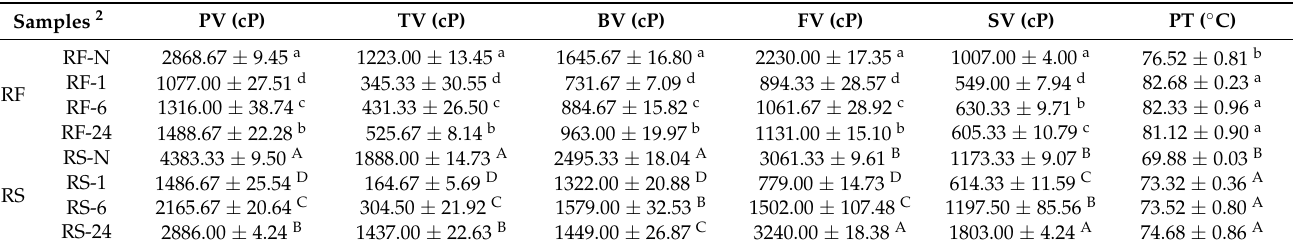
Figure 5. The RVA curves of native and partially hydrolyzed RF and RS. RF represents rice flour and RS represents rice starch; numbers refer to the hydrolysis time (h); RF-N is native rice flour and RS-N is native starch isolated from rice flour. Table 6. The RVA parameters 1 of native and partially hydrolyzed RF and RS.